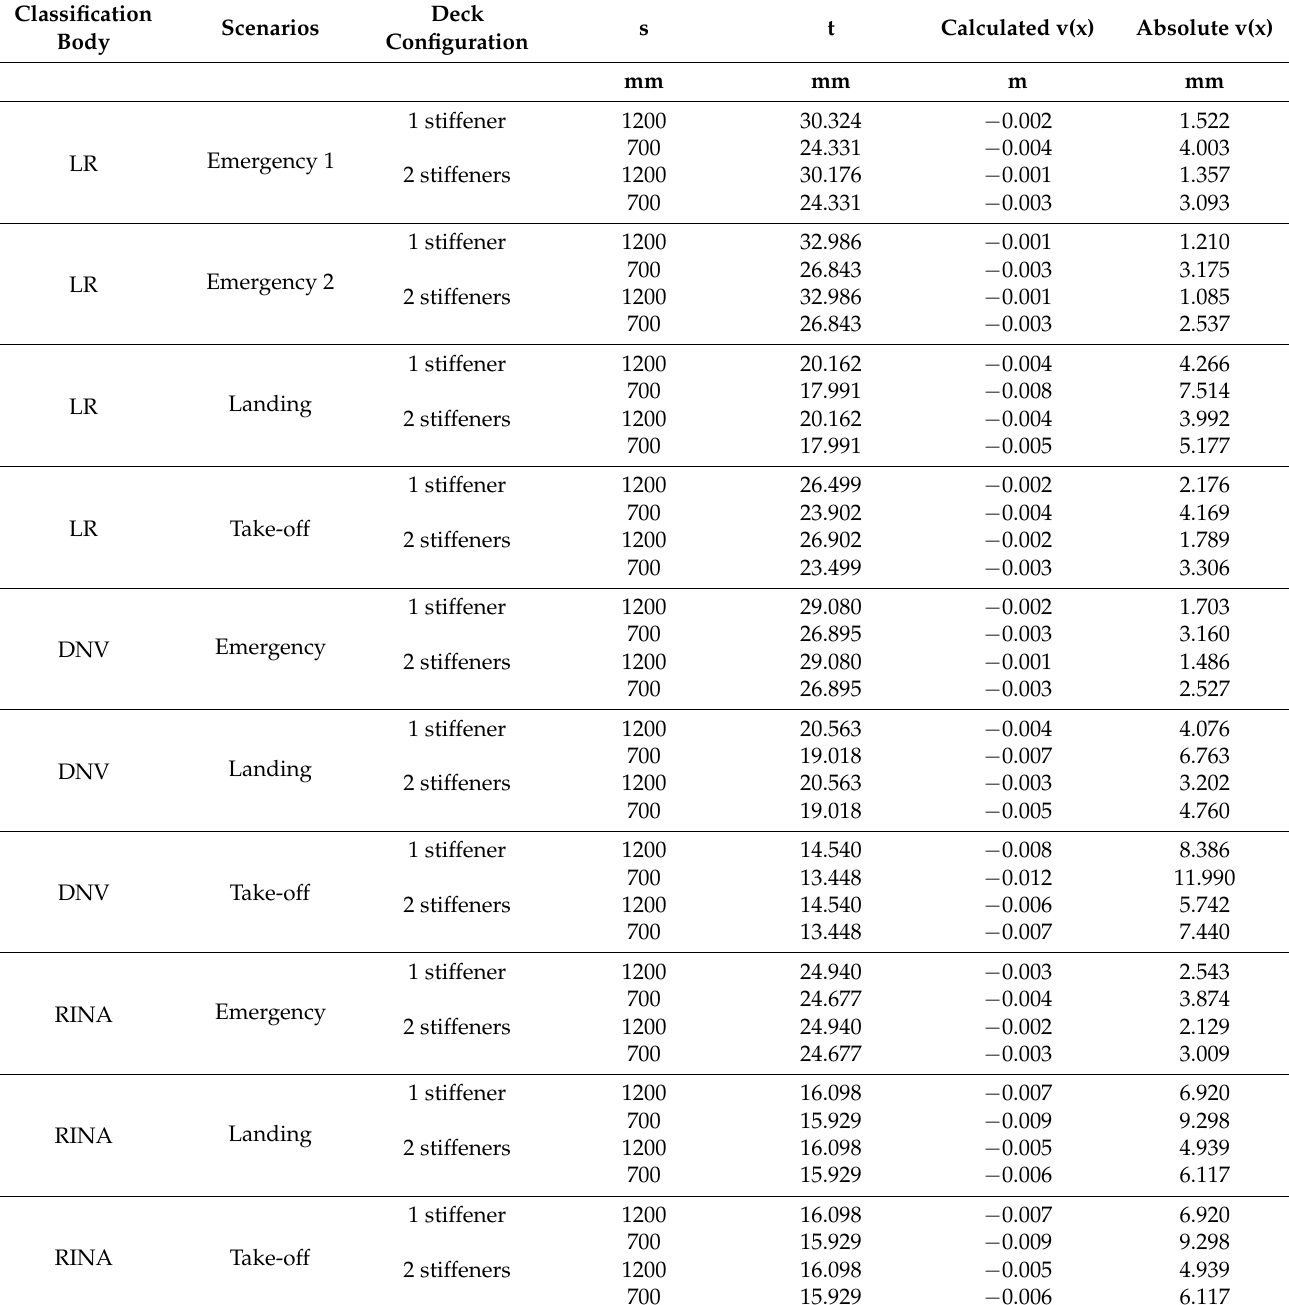
Table 5. Outputs of the numerical analyses performed under the UDL